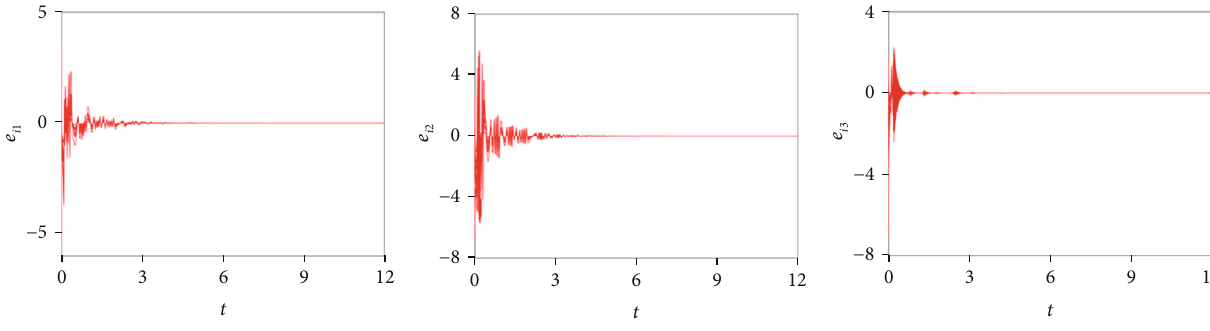
Figure 3: Synchronization errors e